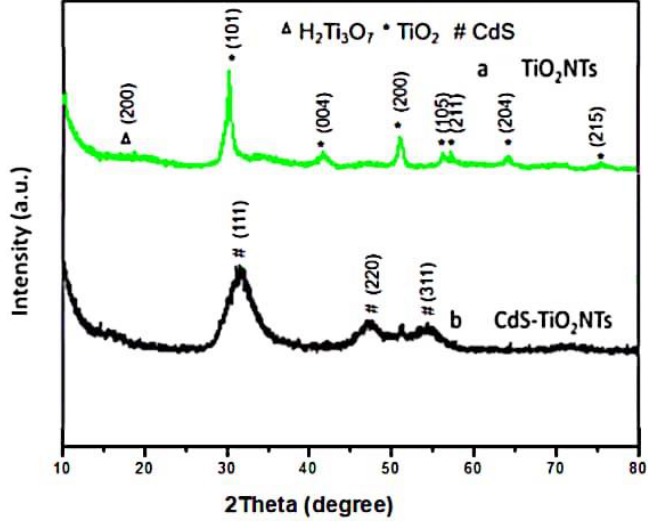
Figure 3. XRD patterns of TiO 2 NTs (a) and CdS-TiO 2 NTs (b).